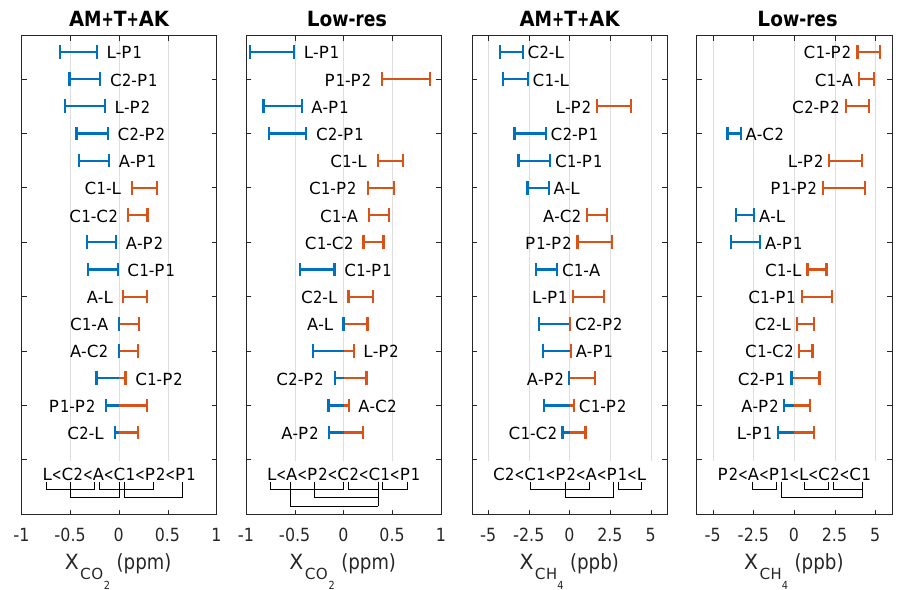
Figure 10. Pairwise 95% CI of differences between sites. Differences for data within ± 2h local noon. Comparisons are ranked in order of decreasing mean difference. For each species, plots are shown for (1) corrections for air mass, differences in temperature sensitivity errors defining temperature errors layer by layer, and a reduction of the smoothing error from different averaging kernels; (2) differences by comparing results from 125HR spectra with lowered resolutions. At the bottom are the site orderings. Lines between indicate when the pairwise difference is first more than